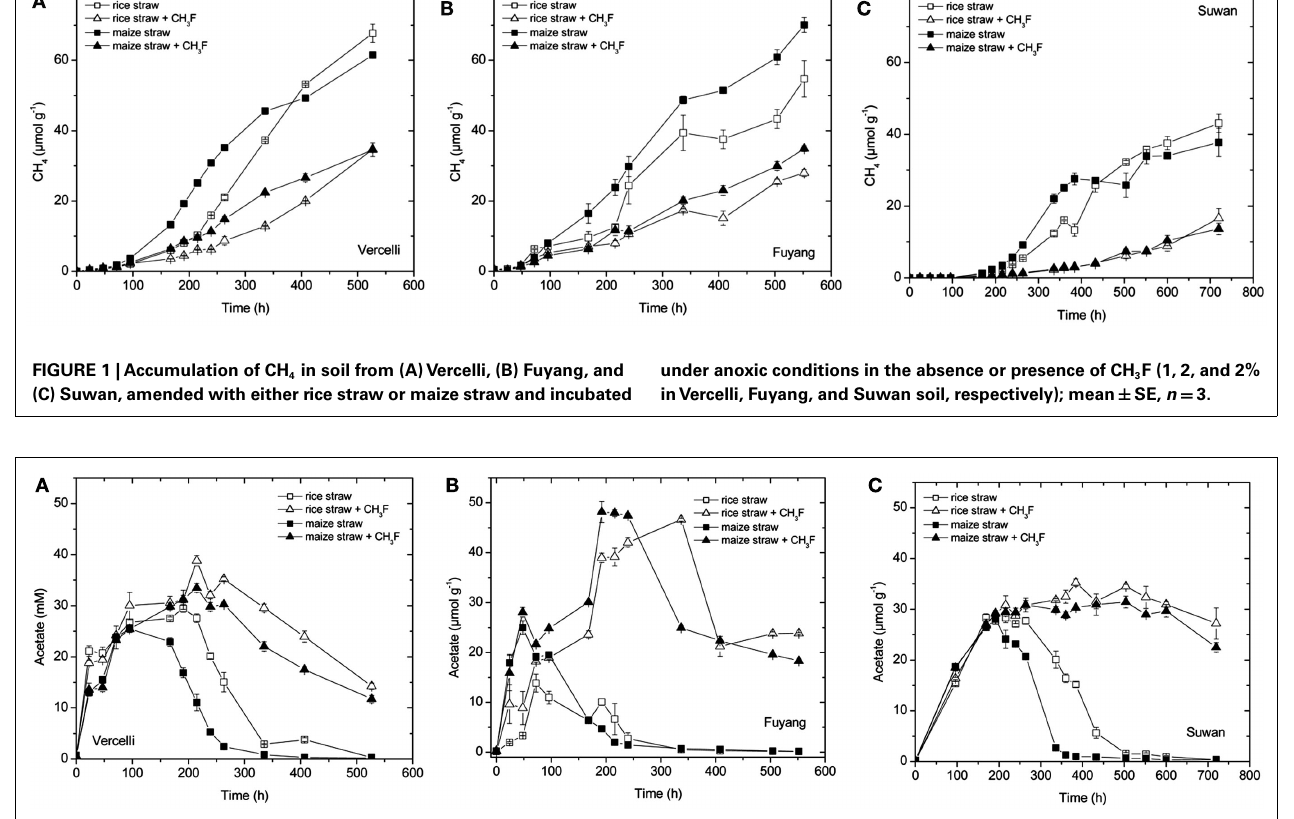
FIGURE 2 |Transient accumulation of acetate in soil from (A)Vercelli, (B) Fuyang, and (C) Suwan, amended with either rice straw or maize straw and incubated under anoxic conditions in the absence or presence of CH 3 F (1, 2, and 2% inVercelli, Fuyang, and Suwan soil, respectively); mean ± SE, n =